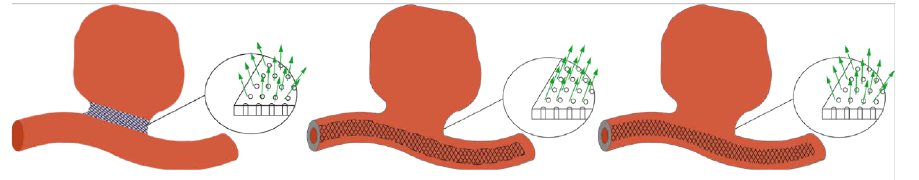
Figure 1. Schematic representation of approaches to stent deployment in Patients. (on the left ) scenario A: the stent is a porous plug in the neck of the aneurysm; (in the center ) scenario B: the stent is a porous tube along the vessel wall (the model is not isotropic); (on the right ) scenario C: the stent is a porous tube along the vessel wall (isotropic model).